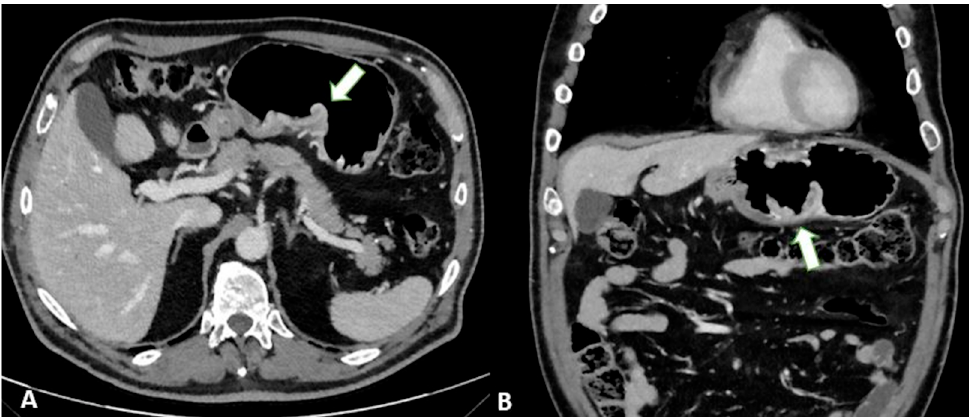
Figure 7. T3 gastric cancer in a 68-year-old female patient. Contrast enhanced CT with gastric dis- tension using air. ( A ) Axial 2D image and ( B ) Coronal 2D image in the portal venous phase with distension of the gastric lumen with air showing a semicircumferential tumor (white arrows) of the low body of the stomach with ulcerations.